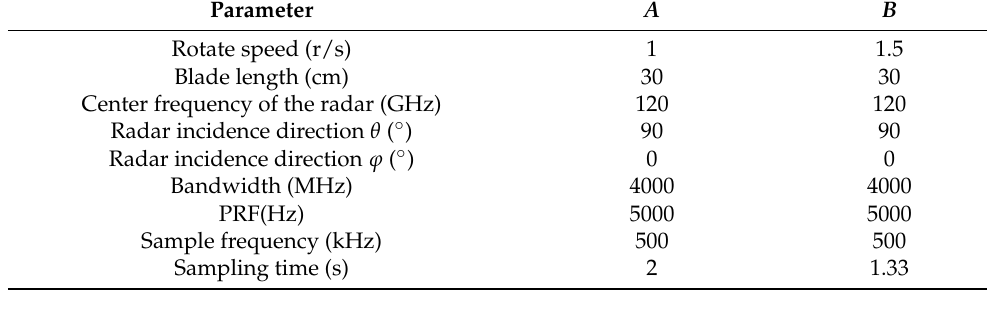
Table 2. Table of parameters of the helicopter rotor micro-motion experiment.